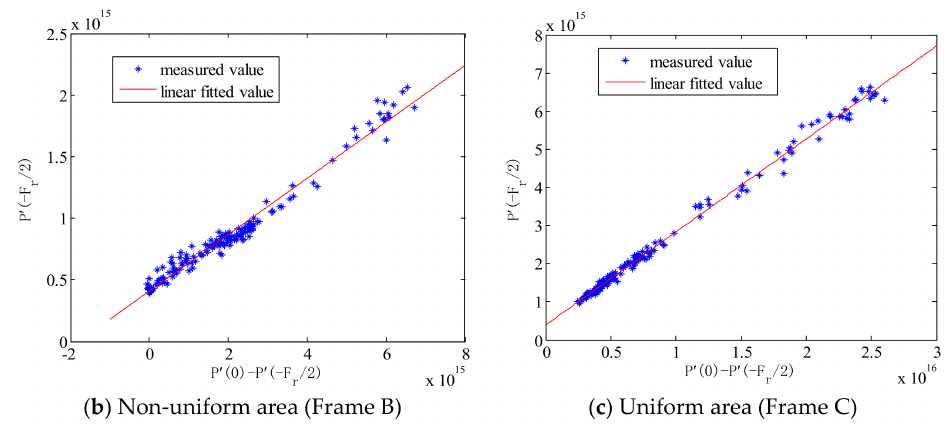
Figure 10. The comparison of statistical results between the uniform and non-uniform scattering regions in the second example. ( a ) Relationship between P (cid:48) ( 0 ) − P (cid:48) ( − F r /2 ) and P (cid:48) ( − F r /2 ) in Frame A, and the goodness of fit for the curve is 0.9994; ( b ) Relationship between P (cid:48) ( 0 ) − P (cid:48) ( − F r /2 ) and P (cid:48) ( − F r /2 ) in Frame B, and the goodness of fit for the curve is 0.9954; ( c ) Relationship between P (cid:48) ( 0 ) − P (cid:48) ( − F r /2 ) and P (cid:48) ( − F r /2 ) in Frame C, and the goodness of fit for the curve is 0.9984.